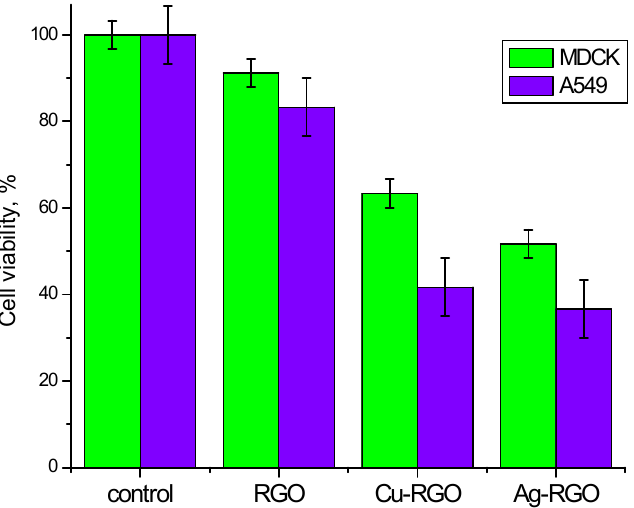
Figure 11. Cell viability after 24 h treatment with RGO and metal–RGO composites.